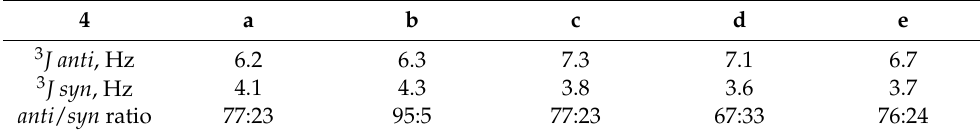
Figure 1. Diastereoisomers of flavonoids 4a – e . Table 1. Coupling constants H-2–H-3 and diastereoisomers ratio of flavanones 4a – e .